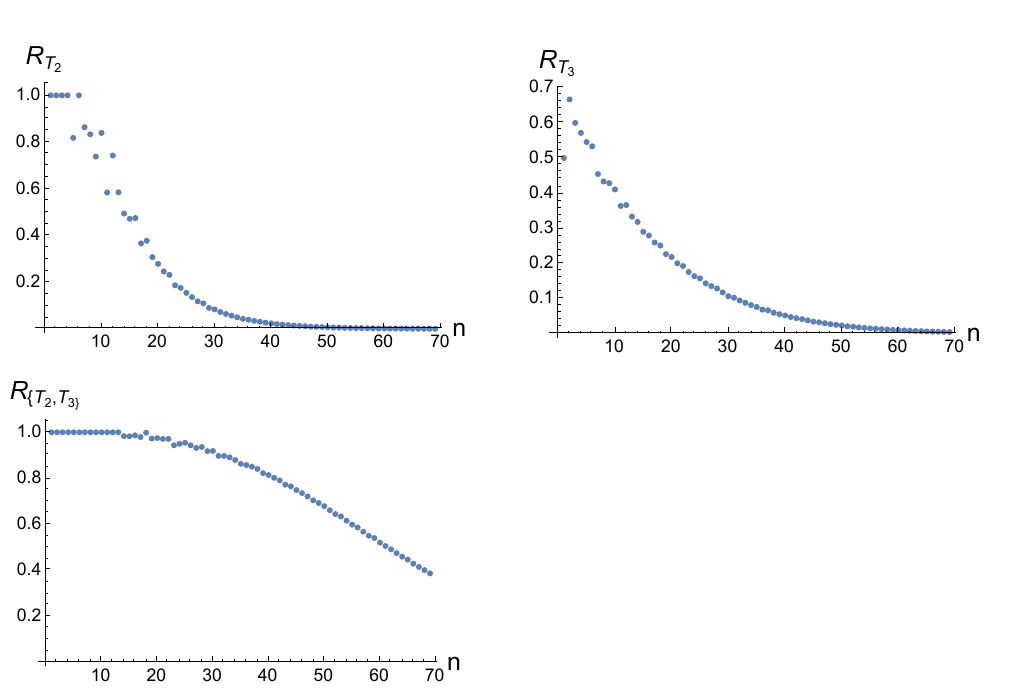
Figure 4 . Figures showing relative dimension plots for T